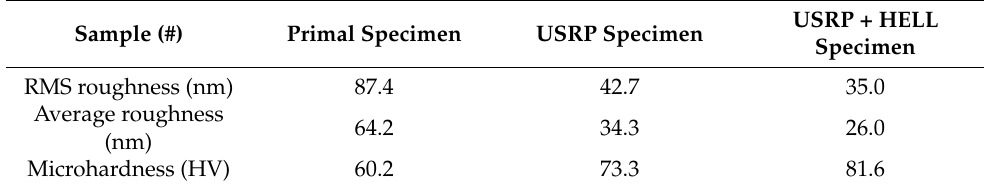
Table 2. Roughness and microhardness